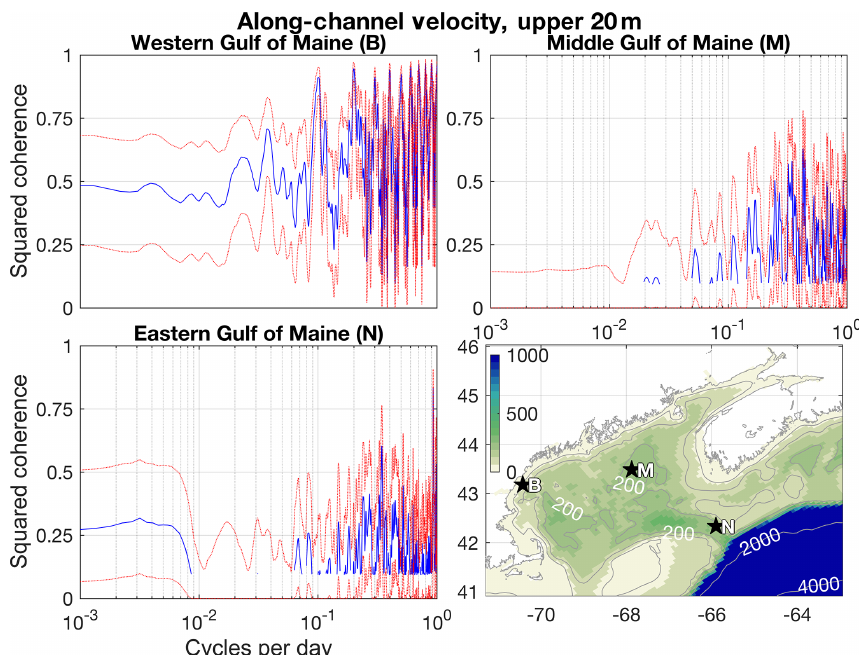
Figure 8. Velocity coherences (blue) with 90% confidence limits (red) for three representative moorings across the Gulf of Maine. Where the lower-bound confidence limit is below 0, coherence is not plotted. Doppio has intrinsic skill in coherence at high-frequency and seasonal timescales but falters in the mesoscale. The coastal current variability is captured well at all timescales. These mooring locations are also noted relative to the whole domain in Fig.